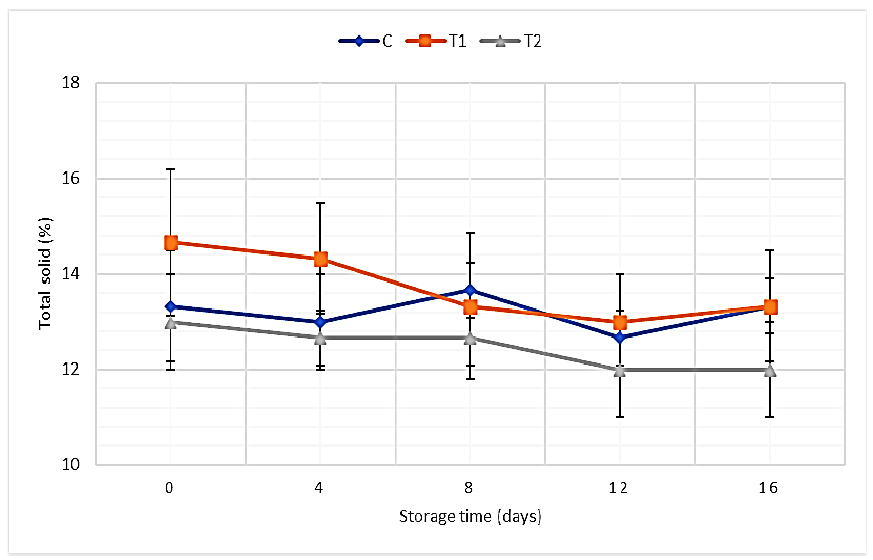
Figure 3. TS percentages of SLY samples without and with REO addition during storage up to 16 days.